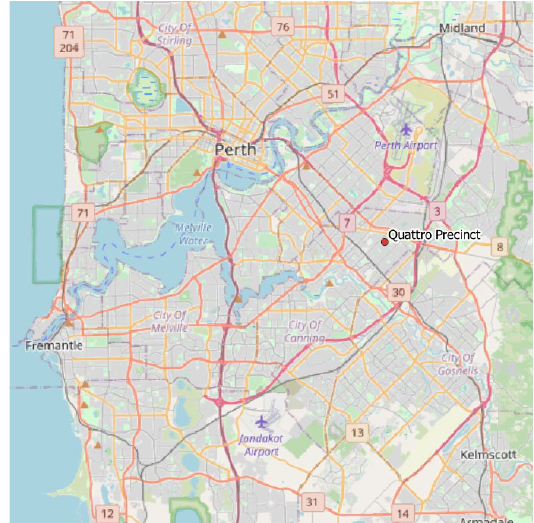
Figure 1: The location of the Quattro Precinct within Perth (data source: Open StreetMaps (www.osm.org)).